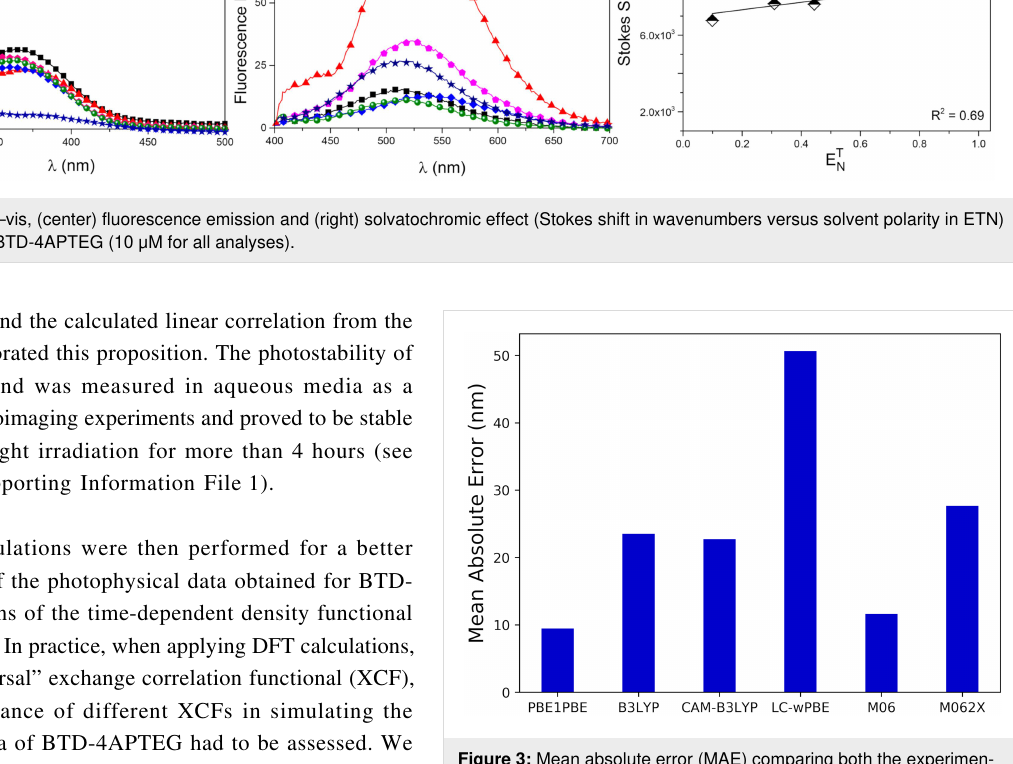
Figure 3: Mean absolute error (MAE) comparing both the experimen- tal and the estimated TD-DFT λ max positions in different solvents for BTD-4APTEG. The computed λ max value corresponds to the largest wavelength band associated with the S 0 → S 1 electronic